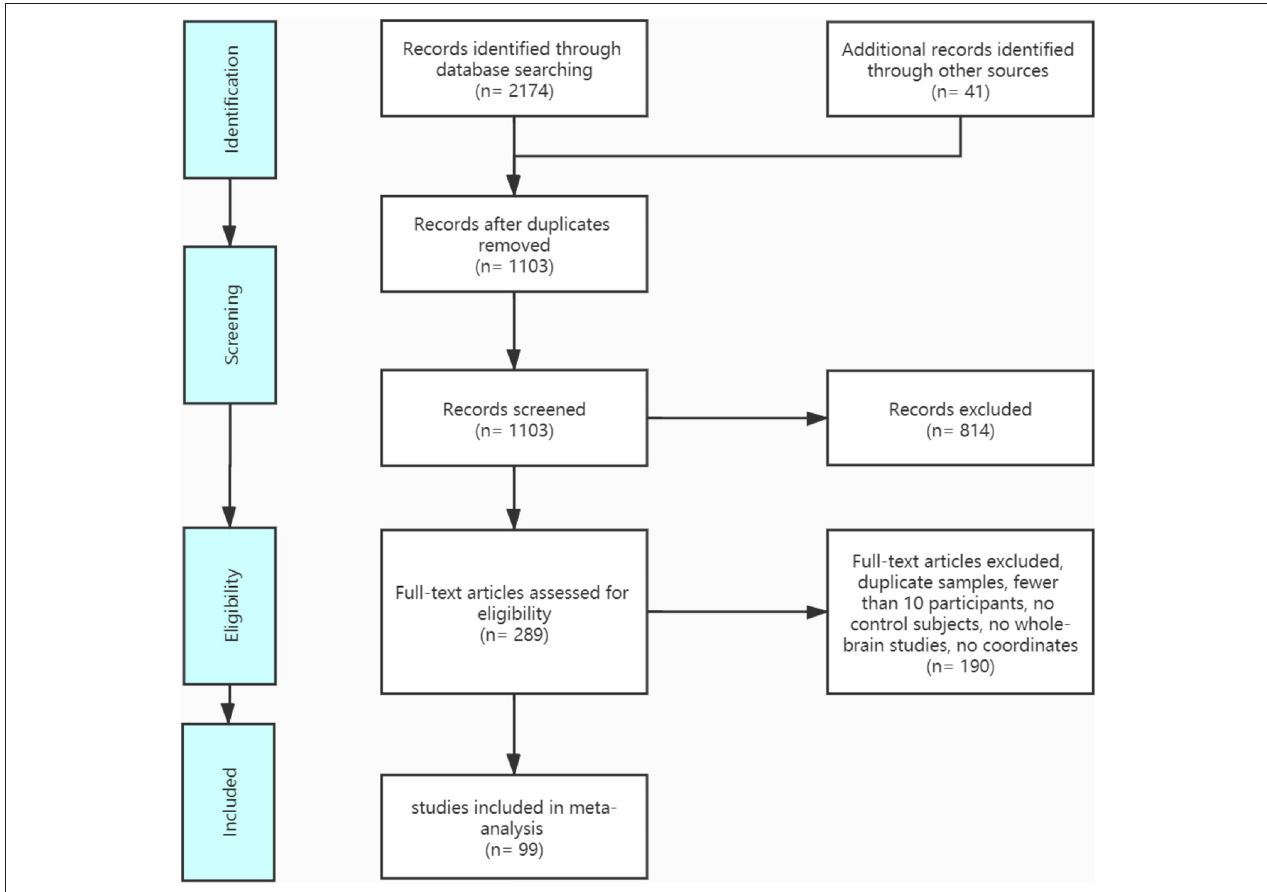
FIGURE 1 | Literature search methods and results for ADHD and IGD fMRI and VBM.